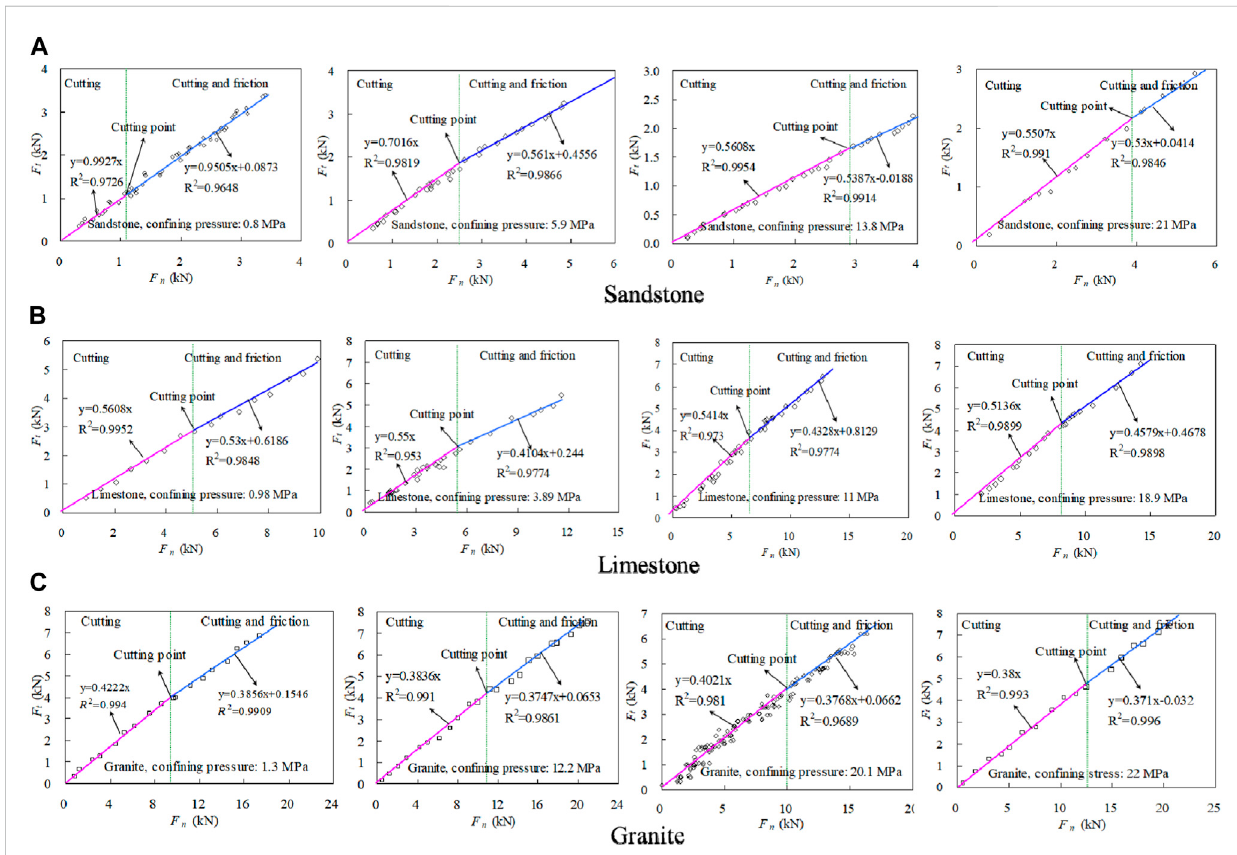
FIGURE 6 Plot of torque force as a function of thrust force at four different con fi ning stresses. (A) Sandstone, (B) Limestone, and (C)